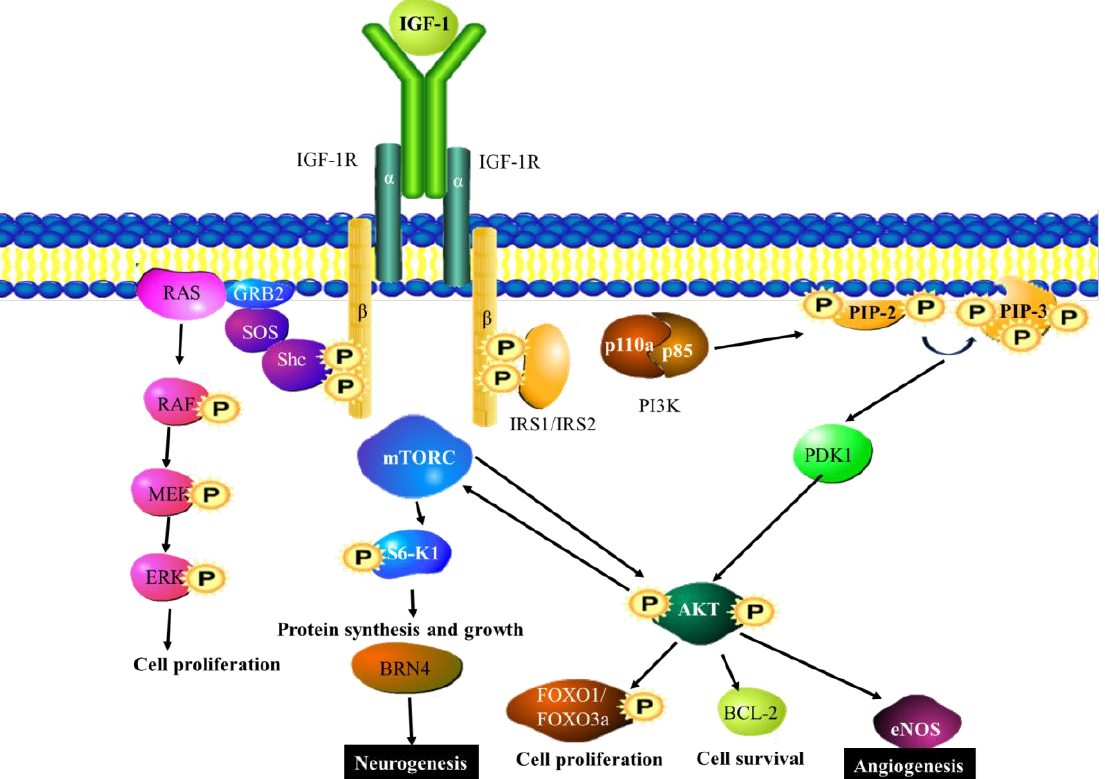
Figure 3. IGF-1 signaling pathways: The binding of IGF-1 to the IGF receptor FGF-1R. The IGF-1 signaling pathway activates the Ras/ERK pathway, which leads to the activation of pro-angiogenic and pro-neurogenic genes. In addition to this, the pathway activates the Brn-4 transcription factor, which stimulates neuronal growth and differentiation. BRN4—POU domain, class 3, transcription factor 4, eNOS—Endothelial NOS, ERK—extracellular signal-regulated kinase, FRS2 β —fibroblast growth factor (FGF) receptor substrate 2, FOXO 1/3a—Forkhead family of transcription factors, GRB1/2—Growth factor receptor-bound protein 1/2, IRS1/2—Insulin receptor substrate 1/2, MEK— Mitogen activated kinase, mTORC—mammalian target of rapamycin complex 1, PDK1—Pyruvate dehydrogenase kinase isozyme 1, PIP-2/3—phospholipase, PI3K—Phosphoinositide 3-kinase, Shp2— Src homology region